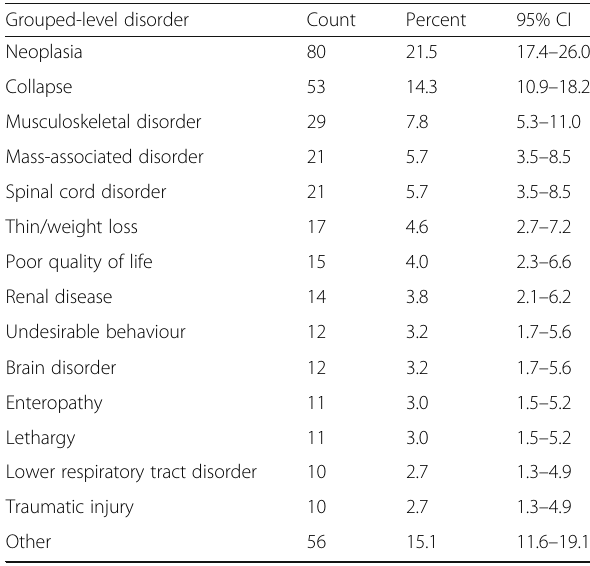
Table 2 Mortality in greyhounds with a recorded cause of death under primary-care veterinary at UK practices participating in the VetCompass ™ Programme from January